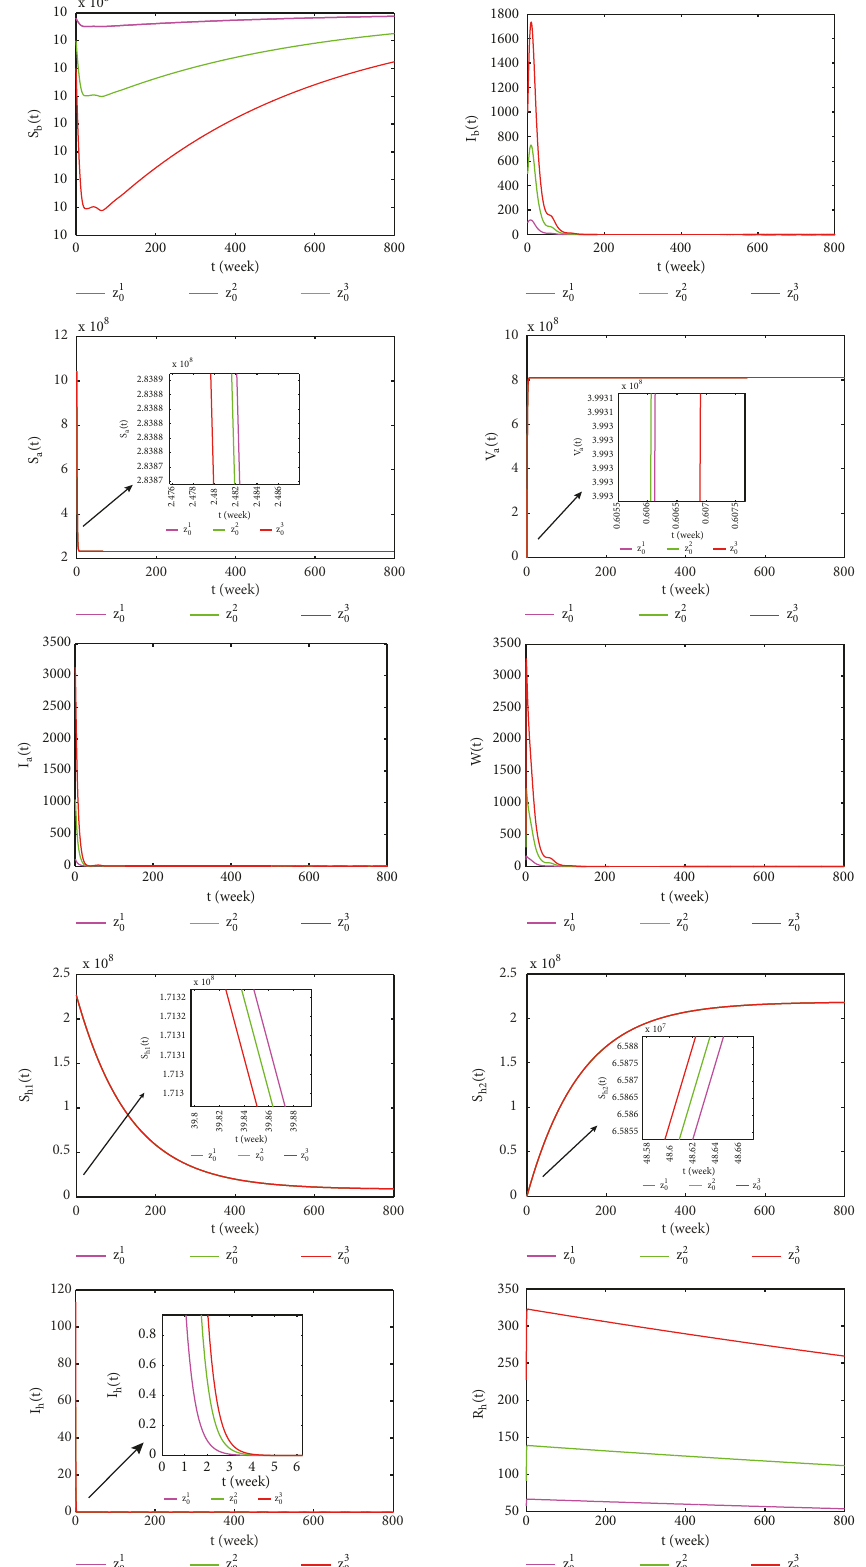
Figure 2: If 𝑅 0 = 0.8575 < 1 , the time-variation diagram of system (1) state